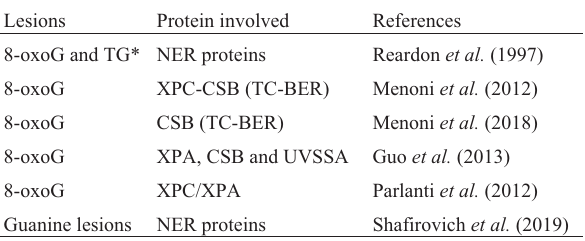
Table 1 - Oxidative lesions recognized by NER factors.